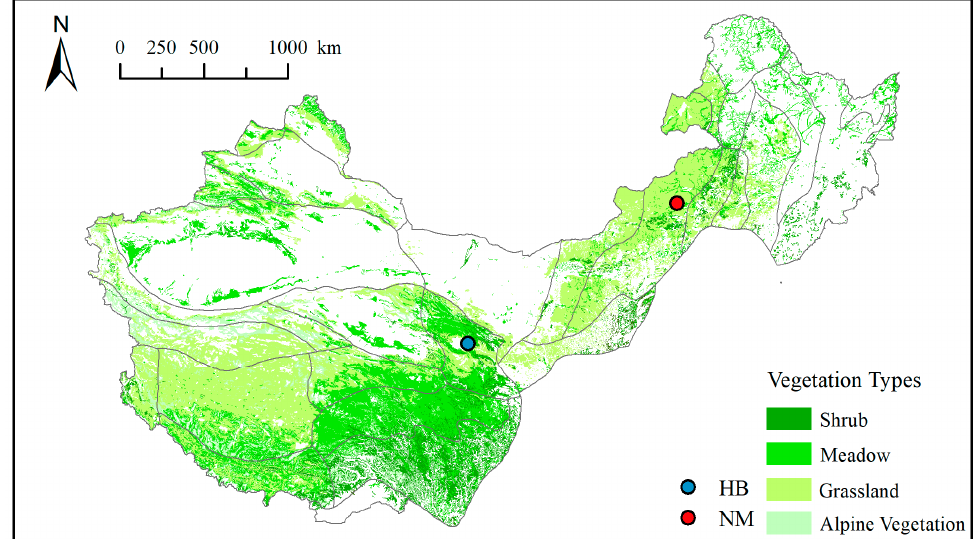
Figure 1. The geographical locations and vegetation types of the two sites, Haibei (HB) and Inner Mongolia (NM), in this